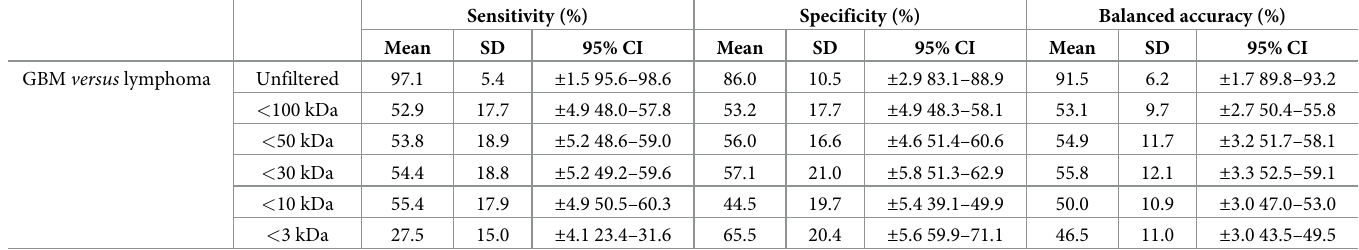
Table 3. Sensitivity, specificity and balanced accuracies for the PLS-DA model classification of GBM versus Lymphoma patients. Mean, standard deviation (SD) and 95% confidence intervals (CIs) are